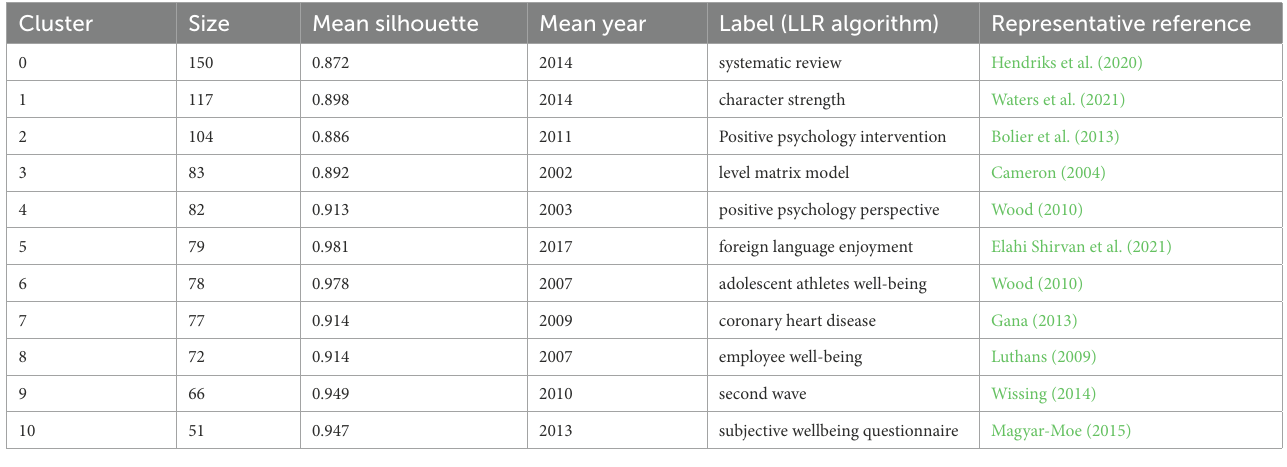
TABLE 5 The largest 11 clusters of references in the co-citation network.